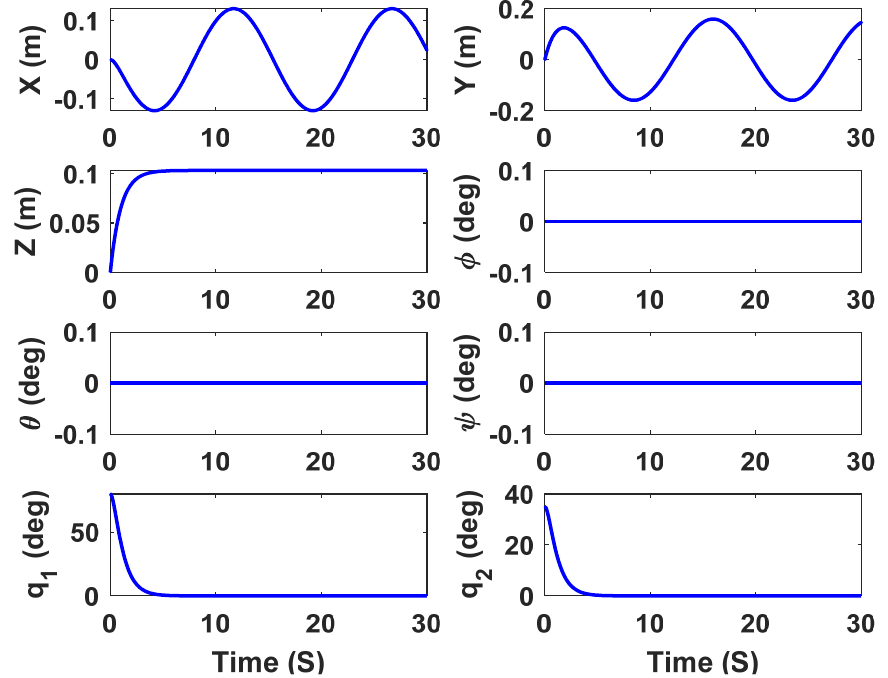
Figure 6. State’s error for the first control case.